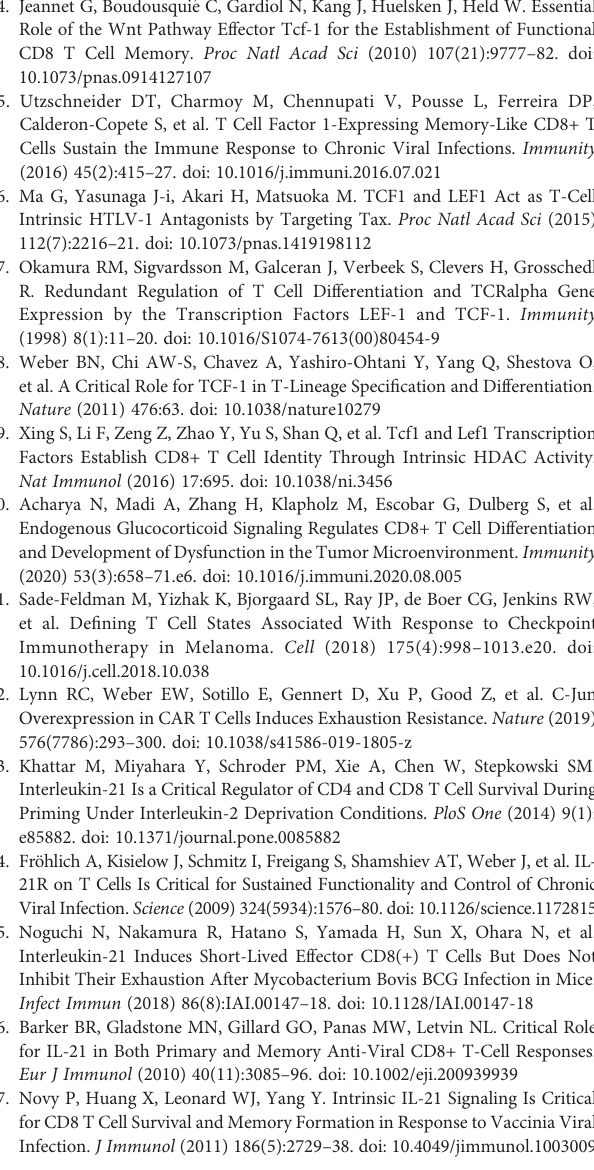
Supplementary Figure 7 | Normal T-cell development in the thymus of compound mutant mice. (A) Generation of compound mutant mice. (B, C) T-cell development in the thymus of Cbx3 - Lef1 -de fi cient and Cbx3 - Il21r -de fi cient mice was assessed; numbers: percent cells; DN1-DN4: double negative (CD4 – CD8 – ) progenitor T-cell populations gated from bottom left quadrants of top fl ow plots. (D, E) CD4+ and CD8+ ratio was evaluated in mLNs from compound mutant mice; numbers: percent cells. (F, G) mLN naïve (CD44 – CD62L+), effector (CD44 +CD62L – ) and memory (CD44+CD62L+) cells in CD4+ as well as CD8+ T-cell compartments of compound mutant mice were assessed; numbers: percent cells. (H, I) Flow analysis was done to evaluate IL21R expression on mLN CD8+ (H) and CD4+ (I) effector (CD44+CD62L – ), naïve (CD44 – CD62L+) and memory (CD44 +CD62L+) T cells from Cbx3 /HP1 g -de fi cient and Cbx3 - Il21r -de fi cient mice; numbers: percent cells. For all panels, n = 3 for each genotype; representative of 3 experiments.